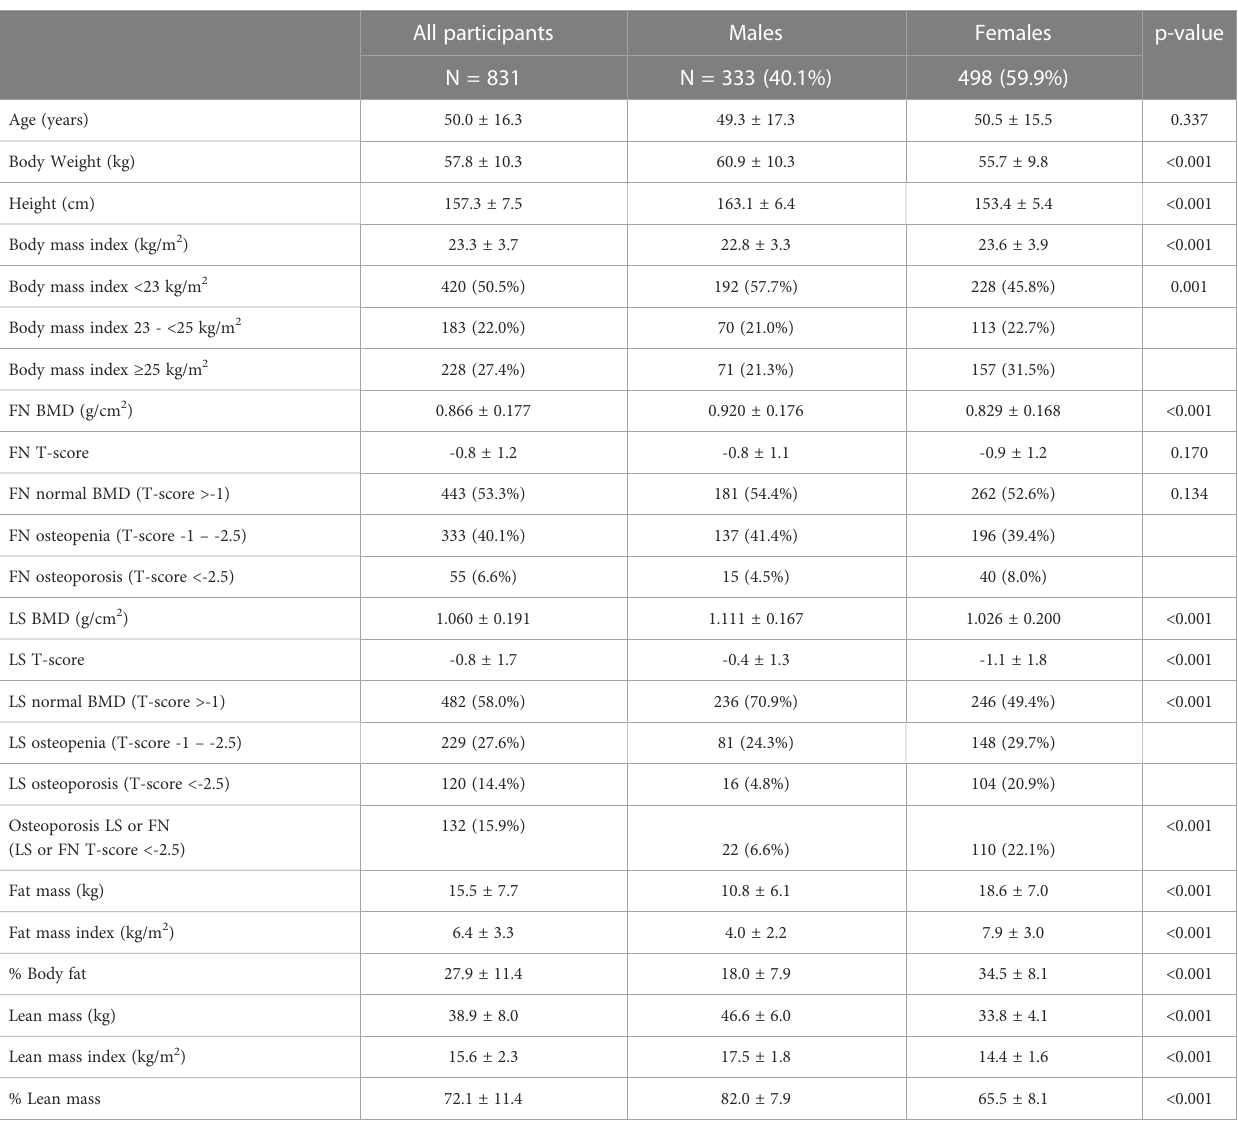
TABLE 1 Characteristics of participants strati fi ed by